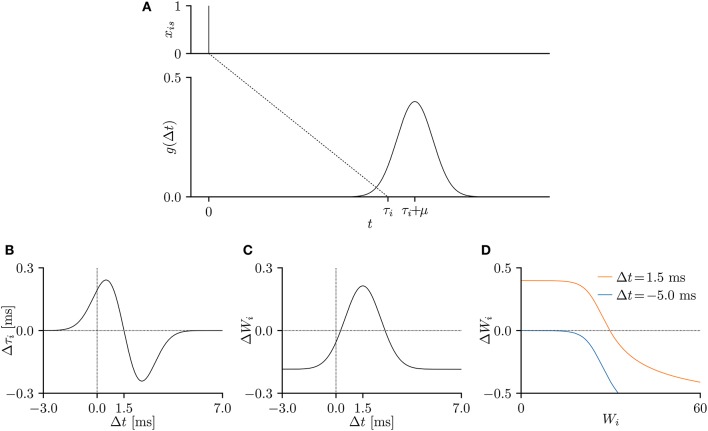
(A) A temporal relation function g(Δt), representing an excitatory post-synaptic potential (EPSP) or current (EPSC), when the pre-synaptic spike is elicited at s = 0 ms. The parameters were set to μ = 1.5 ms and σ = 1.0 ms and the conduction delay τi was set to τ = 10 ms. (B–D) The gradients of the lower bound L(θ) of the model evidence 𝔼x~X[log p(x; θ)] with respect to the parameters Wi and τi. The time step δ was 0.05 ms, the experimental time period T was 50 ms, and the remaining parameters were set to v = 10, and η = 0.001. The gradient shapes depend on the shape of the temporal relation function g(Δt). (B) Temporal window of the delay learning, showing the relationship between the temporal difference Δt and the change Δτi in conduction delay τi, where Δt = s + τi − t. (C) Temporal window of the synaptic plasticity, showing the relationship between the temporal difference Δt and the change ΔWi in synaptic weight Wi. (D) The change ΔWi in synaptic weight Wi versus the current synaptic weight Wi for Δt = 1.5 ms (orange) and Δt = -5.0 ms (blue).